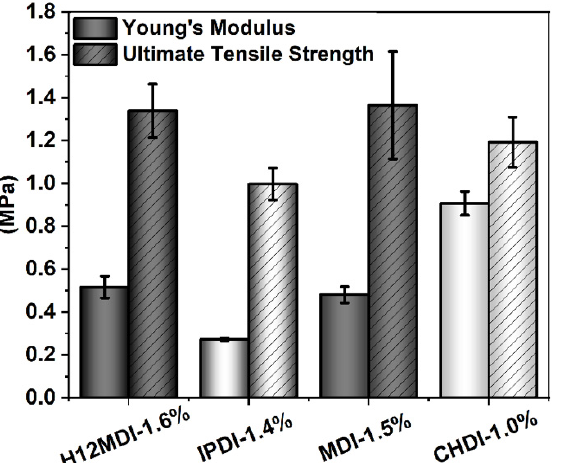
Figure 11. YM (left columns) and UTS (striped-columns) values for PSU copolymers synthesized from the aliphatic diisocyanates H 12 MDI, IPDI, and CHDI, and from the aromatic diisocyanate MDI without chain extenders. The error bars represent the standard deviation from five repeated measurements. YM is lowest for the unsymmetric diisocyanate IPDI and highest for the very sym- metric diisocyanate CHDI. The YM and UTS values are approximately equal for the PSU copolymers synthesized from H 12 MDI and MDI.